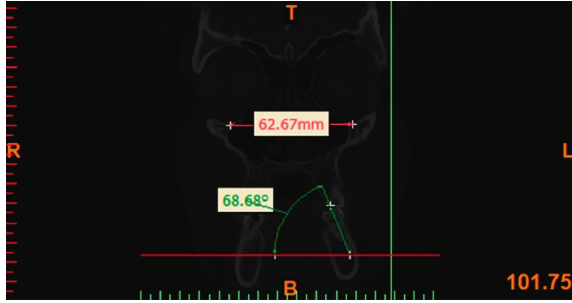
Figure 3: Measuring the inclination of mandibular